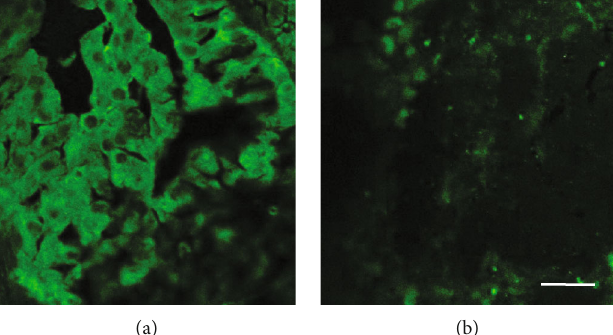
Figure 11: The photomicrograph in (a) depicts the immunohisto fl uorescent labeling of VGSCs (green) observed in a tissue sample taken from the larger tumor mass before treatment with TOL. The immunohisto fl uorescent evaluation of a tissue sample obtained after treatment with TOL in B reveals the signi fi cant reduction in the number of cells that highly express VGSCs. The calibration bar in (b) is 25 μ